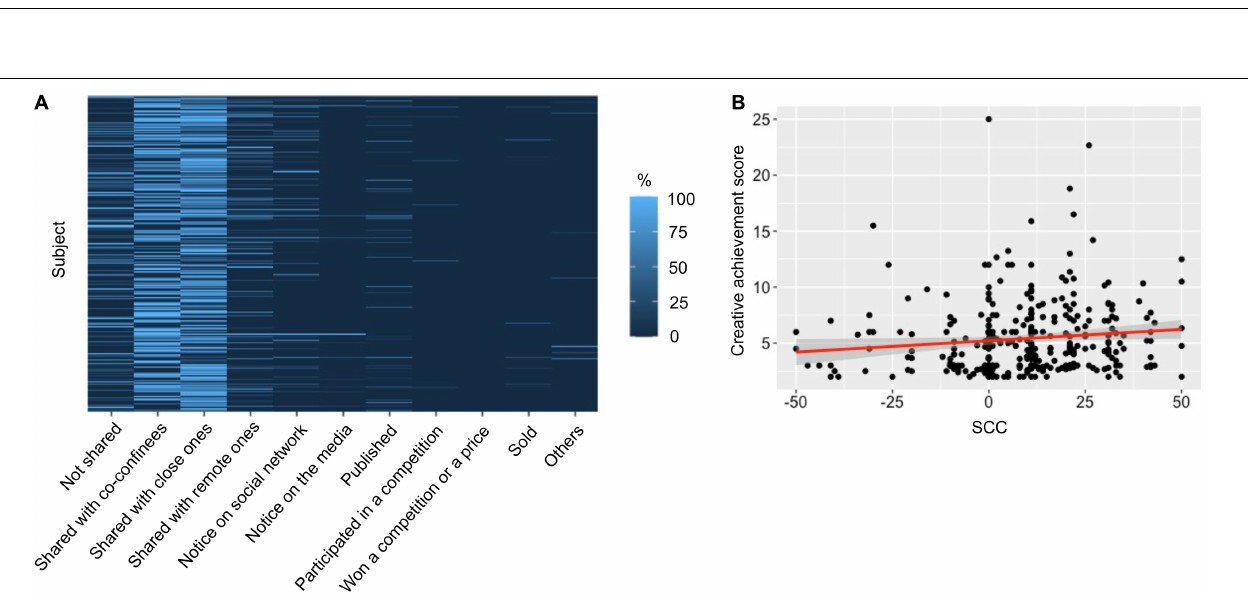
FIGURE 4 | Reported reasons for positive and negative changes in creative activities. (A) Proportions of reasons for positive changes. Each row represents a participant, and reasons are sorted by decreasing average proportion across subjects. (B) Boxplots of the average proportion of reasons for positive changes across subjects. Each dot represents a participant, color boxes represent the upper and lower quartiles, and squares indicate the mean. Stars indicate significant differences between proportions of selected reasons ( post-hoc tests with p corr < 0.05). (C,D) Are the equivalent of (A,B) , respectively, for negative changes.